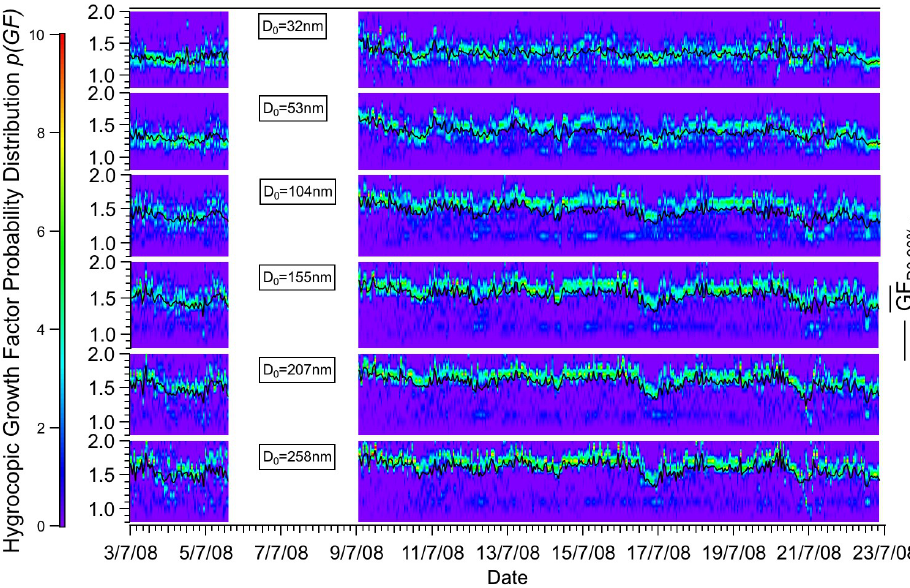
Fig. 5. The HTDMA growth factor probability distribution, p( GF ) , and RH-corrected mean growth factor, GF D0 , 90% , c at 90%, for 6 dry diameters as measured by the